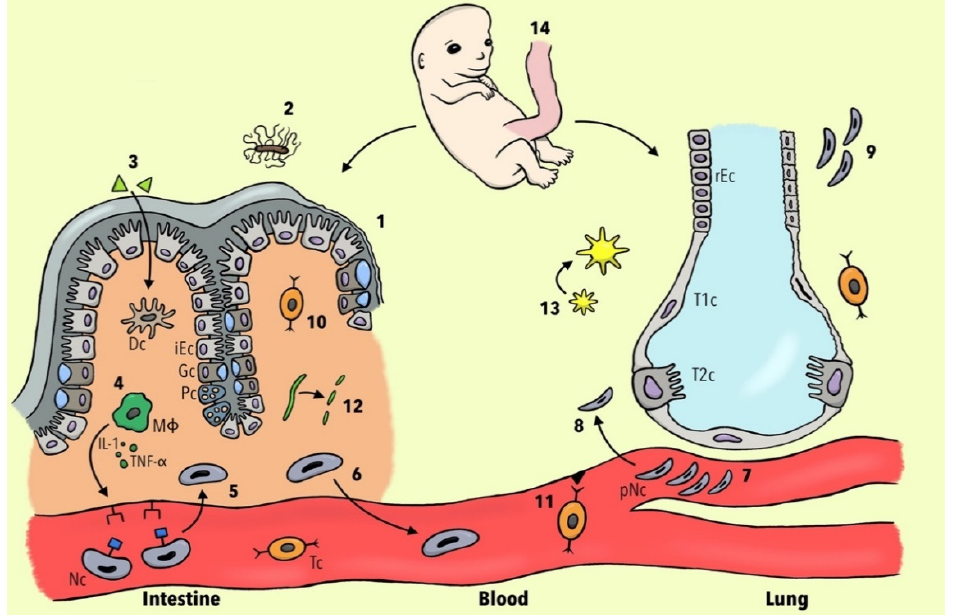
Figure 1. Different pathophysiological concepts of pulmonary manifestations in IBD patients. (1) Mutation of the CARD-15 gene leads to a diminished expression of α -defensins and consequently to a breakdown of the mucosal barrier. (2) Less Clostridia spp. result in dysregulation of host–commensal relationship and, via the reduction of IL-22, to the alteration of epithelial junction integrity. (3) Luminal antigens penetrate through the leaky intestinal mucosa and activate dendritic cells (DC). (4) Activated macrophages ( ΜΦ ) lead, via IL-1 and TNF- α , to the expression of neutrophils (Nc) adhesion molecules. (5) Nc undergo margination and diapedesis to the intestinal mucosa. (6) Nc become primed and a subset re-migrates to the bloodstream. (7) Nc change their shape and become deformable, resulting in a prolonged transit time in pulmonary capillaries. (8) JAM-C becomes downregulated and therefore the translocation of Nc to respiratory epithelium is facilitated. (9) The injured lung is not able to de-prime Nc leading to more neutrophilic inflammation. (10) Inflamed intestinal tissue leads to the upregulation of non-tissue-specific T-cell receptors CCR3 and CXCR5. (11) Diapedesis of gut-memory T cells (Tc)) via non-specific endothelial receptors to lung tissue is increased. (12) Collagen becomes degraded to tripeptide proline-glycine-proline, which plays a role in chemotaxis of Nc. (13) Increased bacterial burden leads to the expression of platelet-activating factor receptor and subsequently to the overexpression of the inflammasome. (14) Gut and lung tissues share the same embryological origin in the foregut portion of the endoderm. Abbreviations: iEC, intestinal epithelial cell; rEC, respiratory epithelial cell; Gc, goblet cell; Pc, Paneth cell; T1c, Type 1 pneumocytes; T2c, Type 2 pneumocytes; IL-1, interleukin 1; TNF- α , tumor necrosis factor alpha; pNC, primed neutrophils.